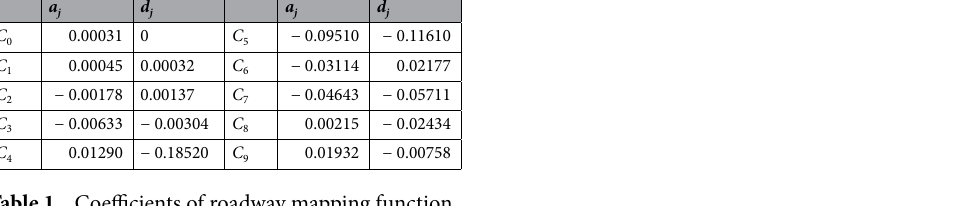
Table 1. Coefficients of roadway mapping